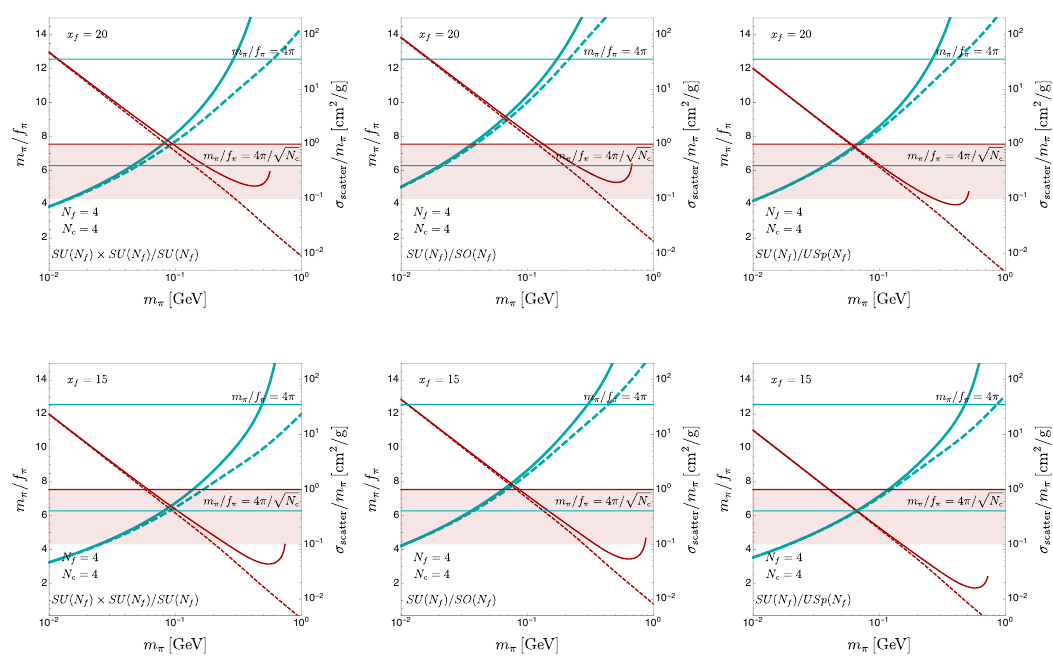
Figure 5 . Shown are m π - m π /f π plots. We assume different symmetry structures for each panel: (left) SU( N f ) × SU( N f ) / SU( N f ) , (middle) SU( N f ) / SO( N f ) , and (right) SU( N f ) / USp( N f ) . We assume N f = 4 and N c = 4 . We take the different x f : (top) x f = 20 and (bottom) x f = 15 . The thick-cyan lines show required m π /f π for given m π (values shown on the left-vertical axis): the thick-solid lines show the result using the improved cross section, while the thick-dashed lines show the result without improvement. The thin-red lines show the self-scattering cross section with m π /f π on thick lines (values shown on the right-vertical axis), and each line-type corresponds to that of thick lines. The red-shaded bands correspond to 0 . 1 cm 2 / g ≤ σ scatter /m π ≤ 1 cm 2 / g . The horizontal solid-lines show the unitary